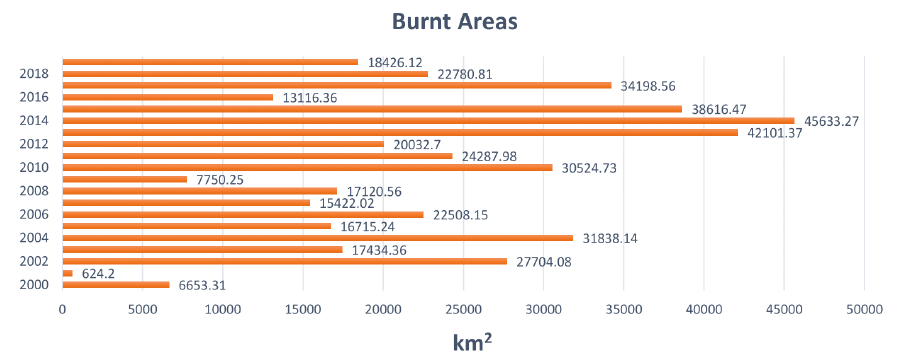
Figure 5. Burnt areas by forest fires in Canada from 2000 to 2019.